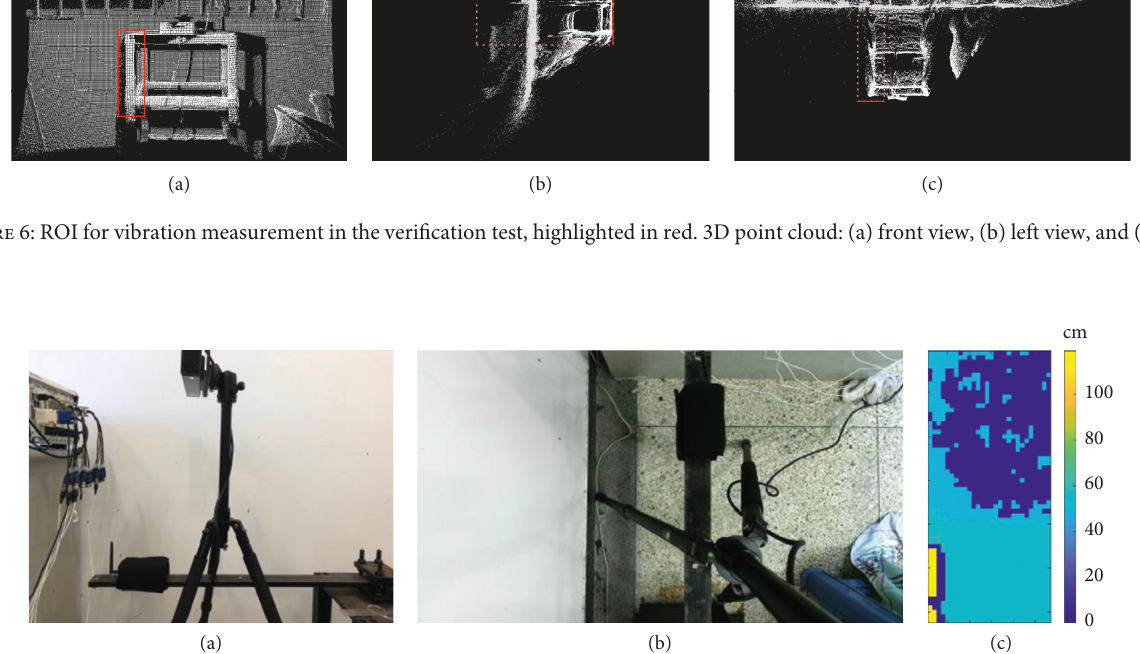
Figure 7: Cantilever steel beam experimental setup for case 1. (a) Vibrometer attached at the end of the cantilever steel beam, Kinect pointing in a direction parallel to the direction of vibration. (b) Field of view (FOV) of Kinect in the RGB image. (c) ROI raw depth information